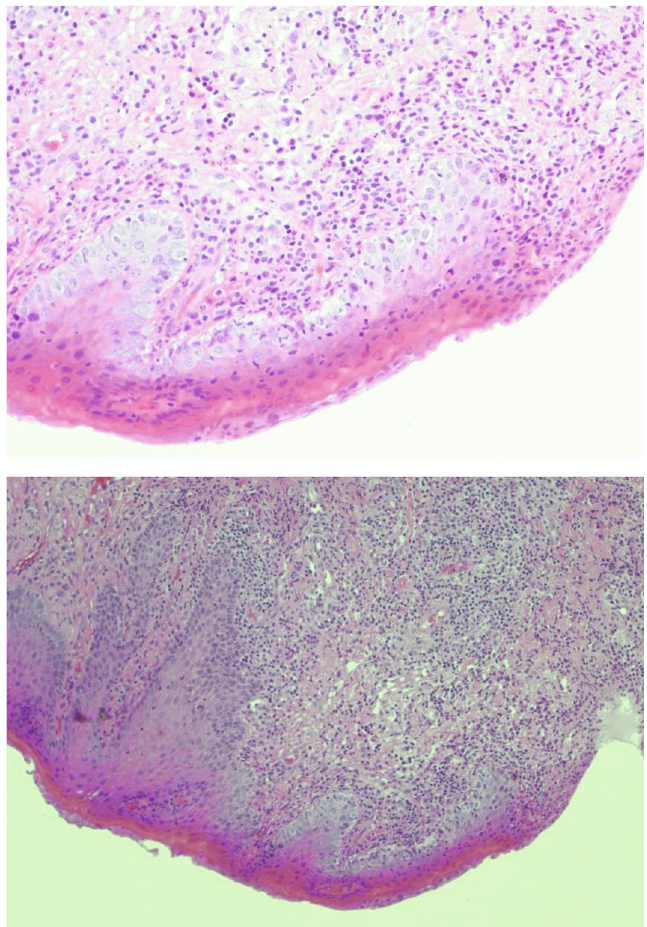
Figure 2: Photomicrograph showed no evidence of squamous cell carcinoma. Bordering the ulcer, granulation tissue presented with a focal collection of in fl ammatory in fi ltrates with some atypical